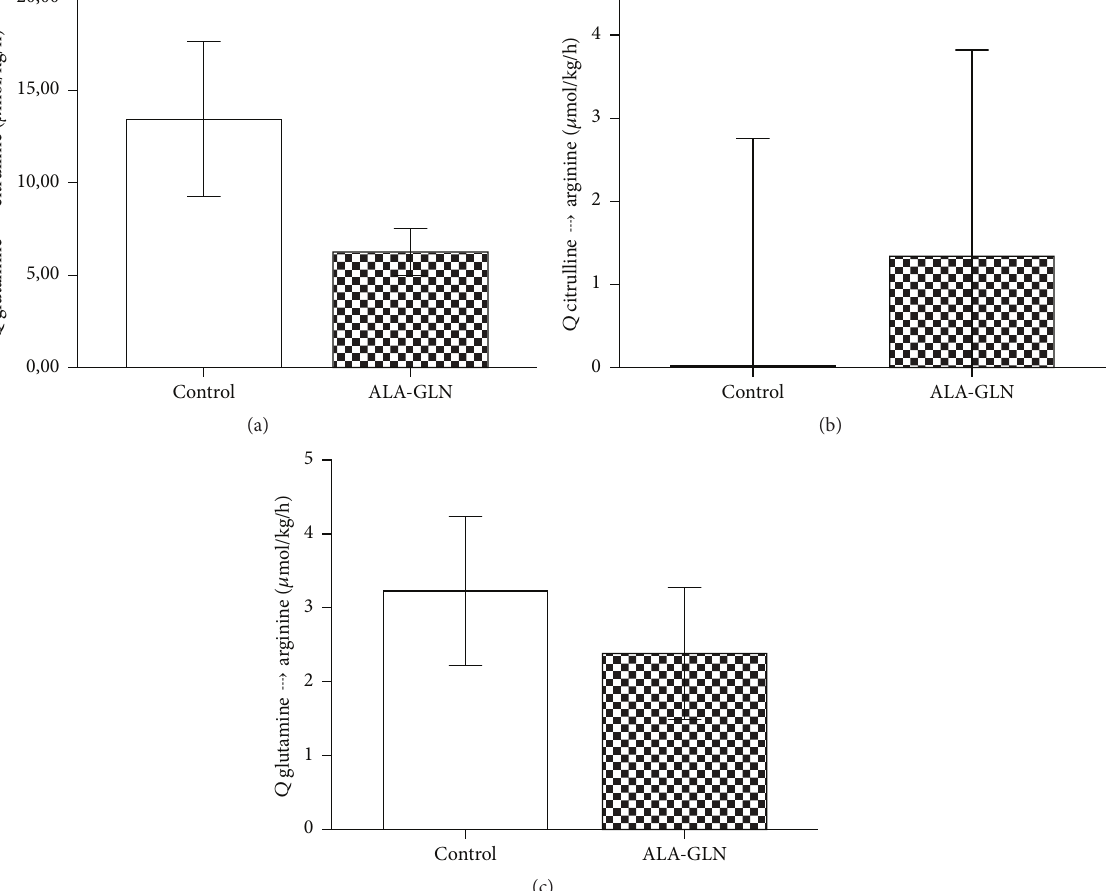
Figure 3: Conversion of glutamine into citrulline and arginine. Conversion rates in 𝜇 mol/kg/h of glutamine into citrulline (a), citrulline into arginine (b), and glutamine into arginine (c). (a) and (c) are expressed in mean ± SE and (b) is expressed in median ± 95%